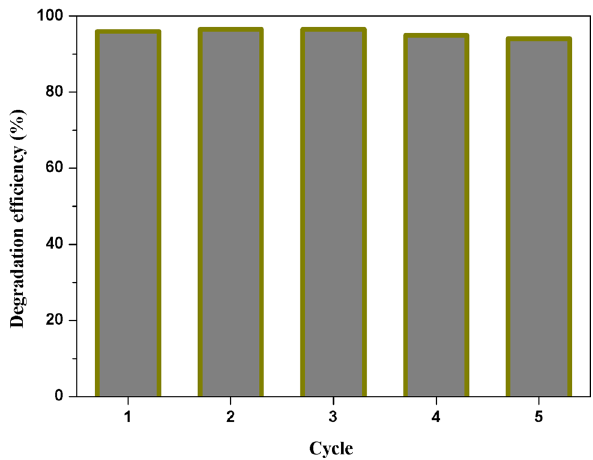
Fig. 7 Reusability of the 30 wt% ZrO cessive